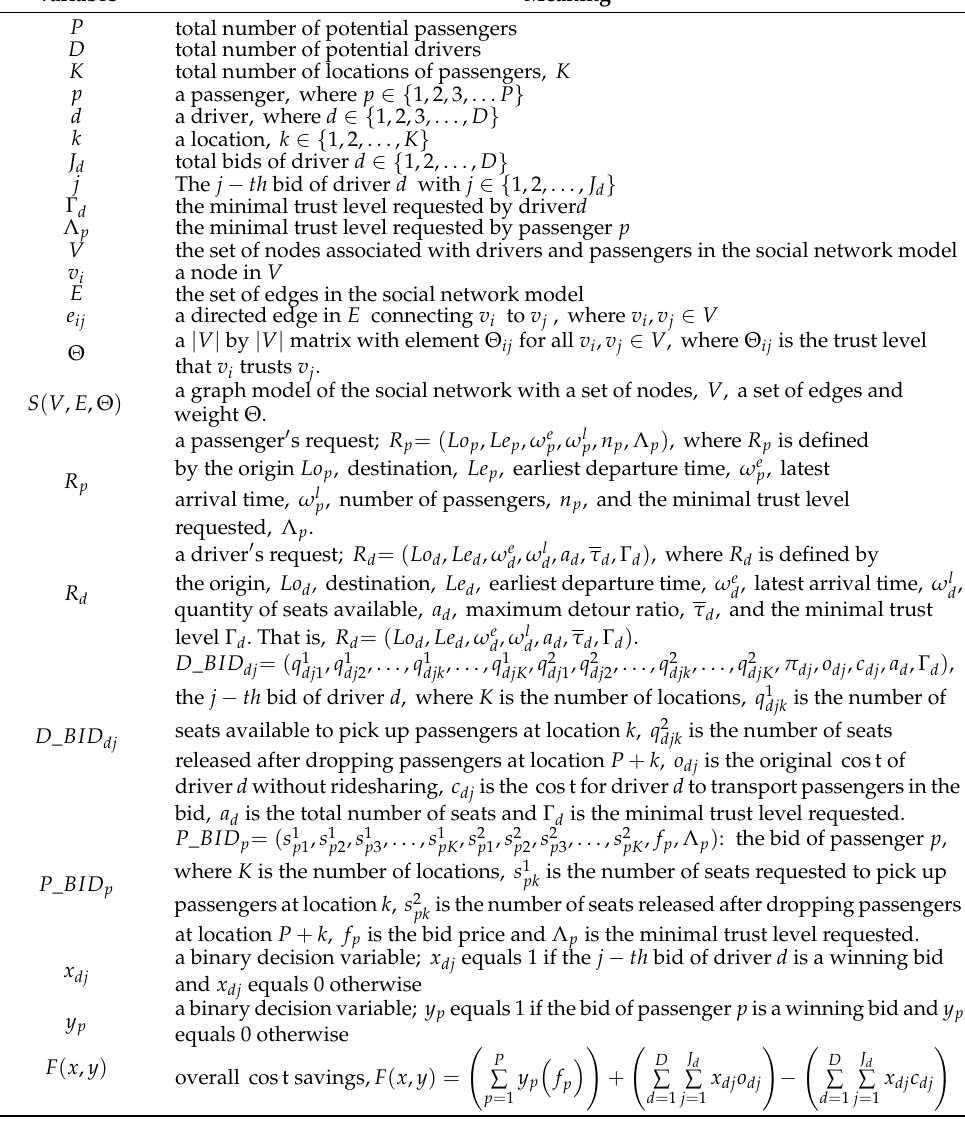
Table 1. Notations of symbols, variables and